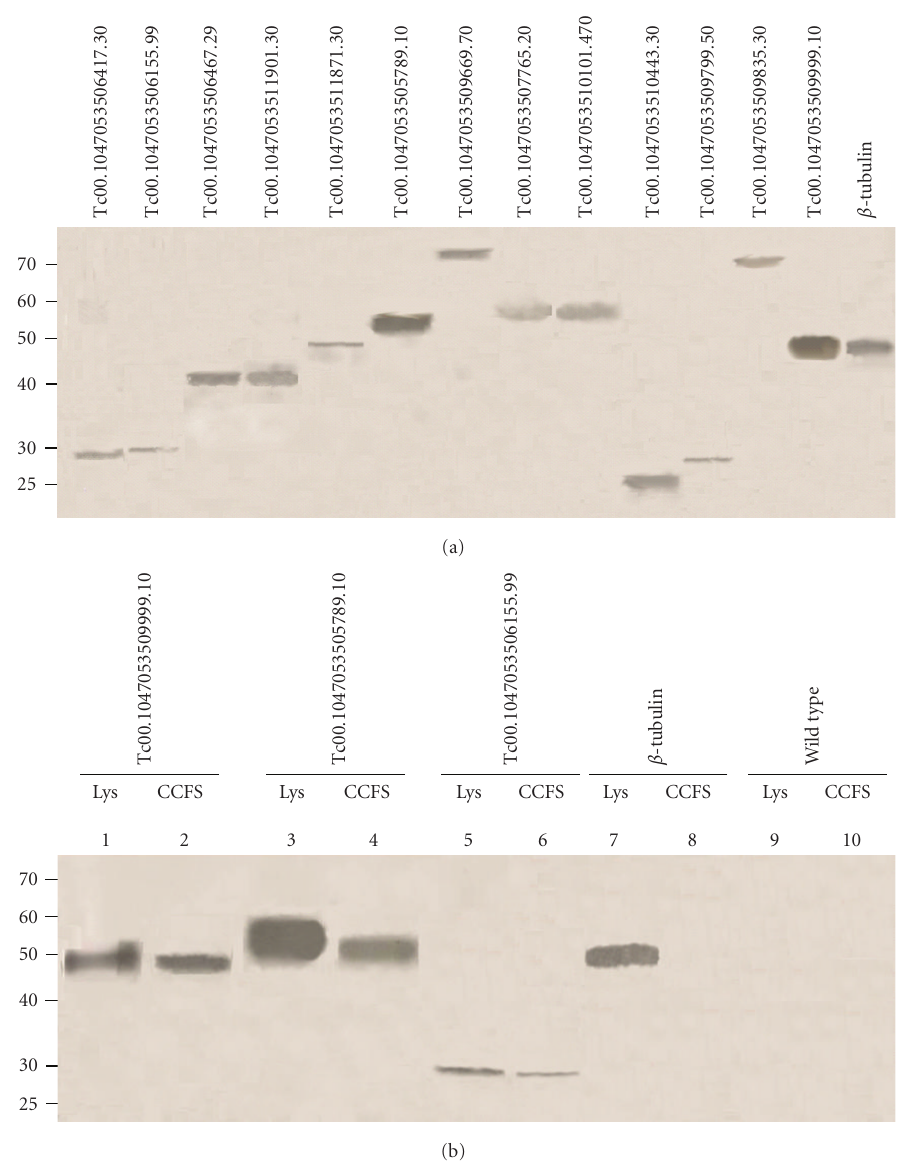
Figure 3: Protein expression in L. infantum episomally transfected promastigotes during the exponential phase of development (a) Western blot analysis of His-tagged proteins detected in whole cell lysate. Equal amounts of total protein (35 μ g) were resolved by electrophoresis in 4–12% gradient gels (Invitrogen), blotted, and developed with anti-HisTag antibody followed by ECL (Amersham). Gene ID and the theoretical molecular weight of detected proteins are listed in order in Table 1. (b) Identification of secreted proteins in whole cell lysate (Lys) and concentrated cell-free culture supernatant (CCFS) obtained from promastigotes incubated for 6 hours in serum-free medium. Note the absence of β Tubulin in the concentrated supernatant of Line 8. Nontransfected L. infantum promastigotes (Wild Type) were used as a negative control. Protein molecular mass standards in kDa are shown on the left of each